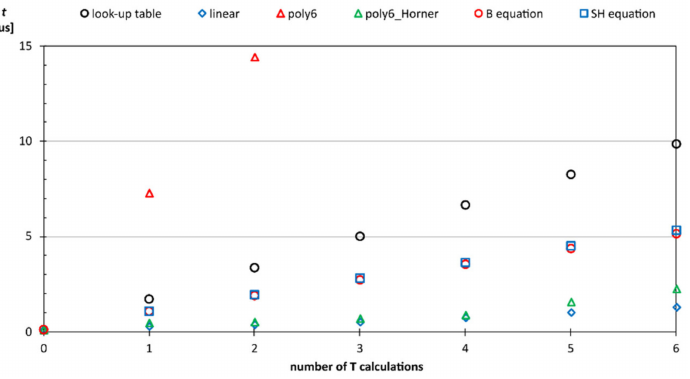
Figure 15. Time comparison of different temperature calculation